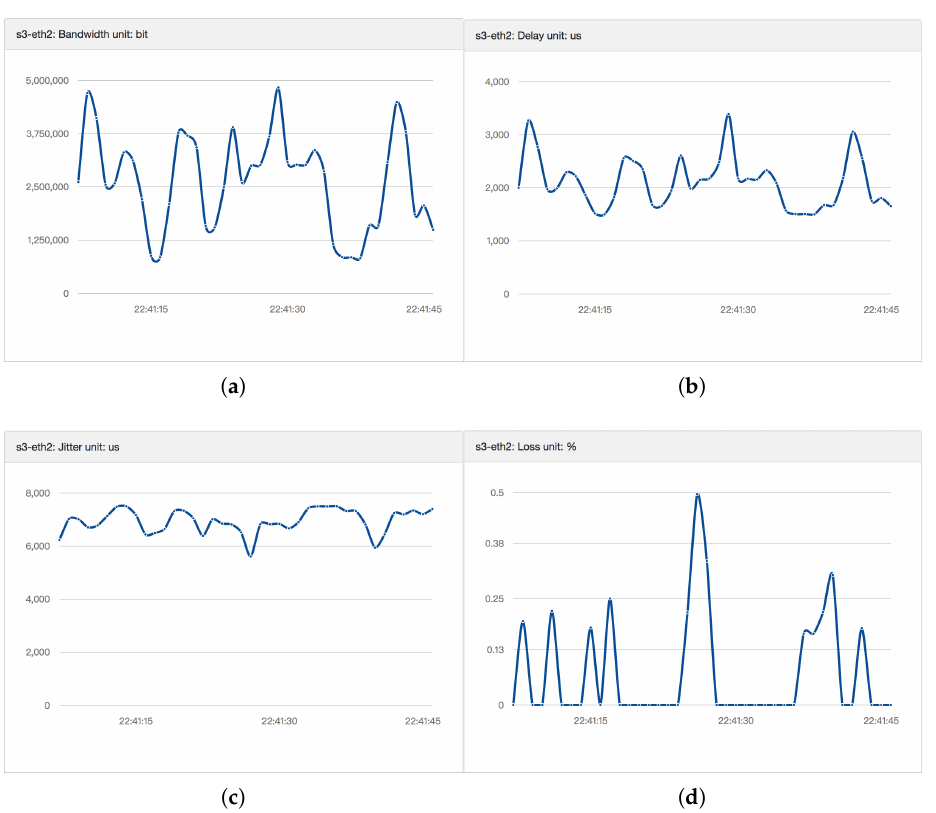
Figure 4. MonLink platform, the statistics page. ( a ) The bandwidth statistics. ( b ) The delay statistics. ( c ) The jitter statistics. ( d ) The packet loss